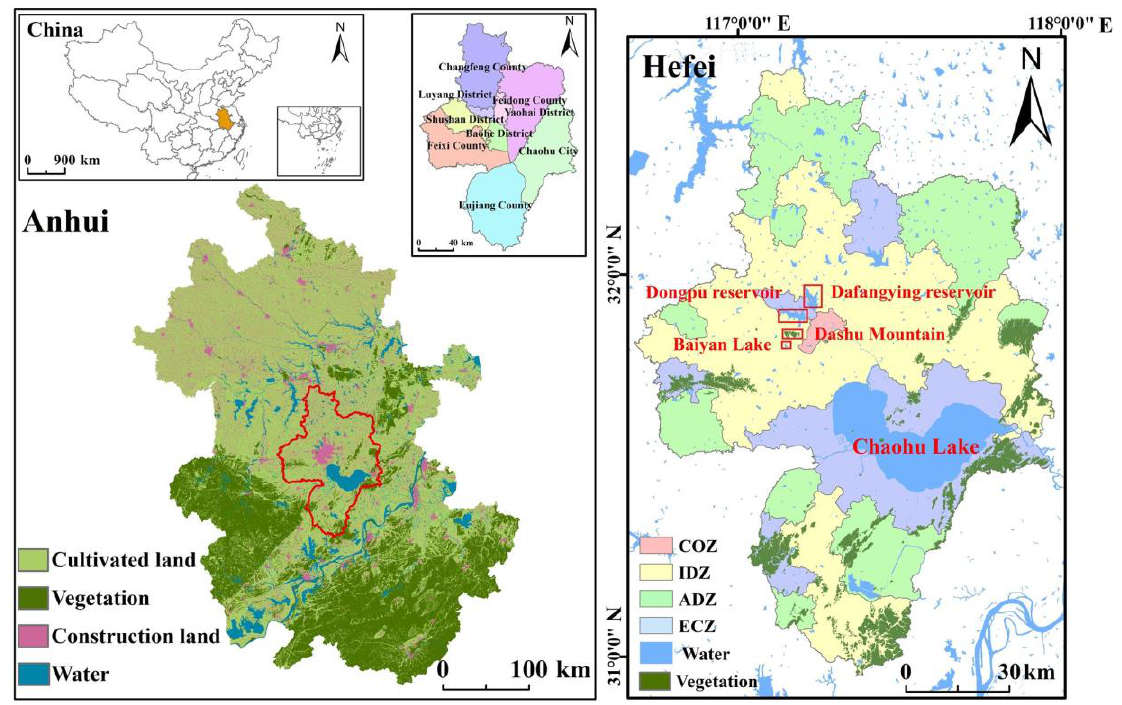
Figure 1. Map of the study area (COZ: core optimization zone; IDZ: new-type urbanization and industrialization cluster development zone; ADZ: agricultural development zone; ECZ: ecological conservation zone).